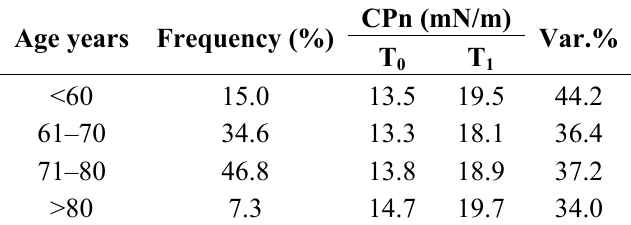
Table 2. Recovery of surface skin energy.